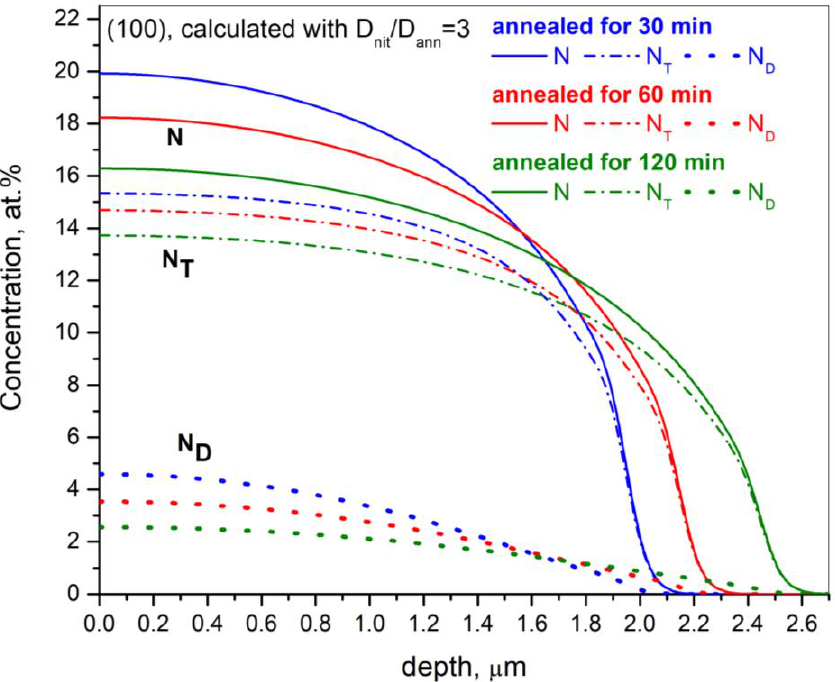
Figure 5. Calculated (with D nit /D ann = 3) depth profiles of nitrogen in the (100)-oriented single crystal of ASS after nitriding (for 60 min at 400 °C) and after isothermal annealing for 30 min, 60 min, and 120 min (at 400 °C). N D — nitrogen in normal lattice, N T — nitrogen in trap sites, and N — total nitrogen concentration.